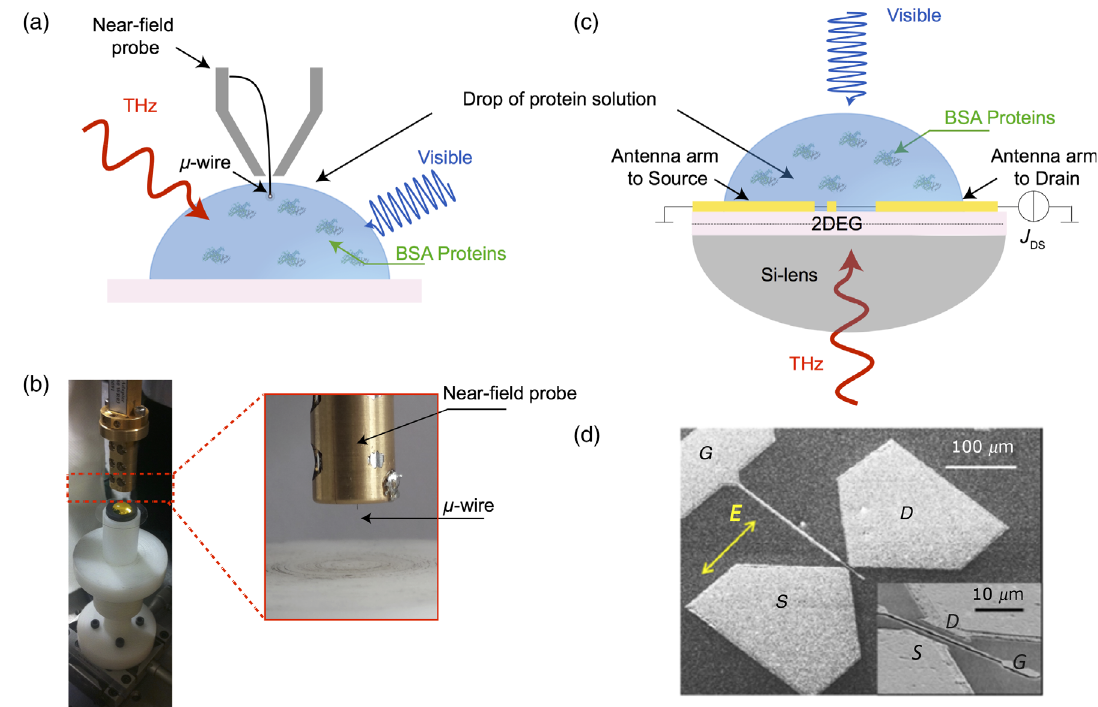
FIG. 3. Experimental setup of THz absorption near-field spectroscopy. (a) A drop of the biological sample placed under the near-field probe, which is directly immersed in the solution. (b) Picture of the near-field probe and its microwire. (c) A drop of the biological sample placed above the near-field rectenna. (d) Electron-beam microscopy picture of the bow-tie antenna with its integrated